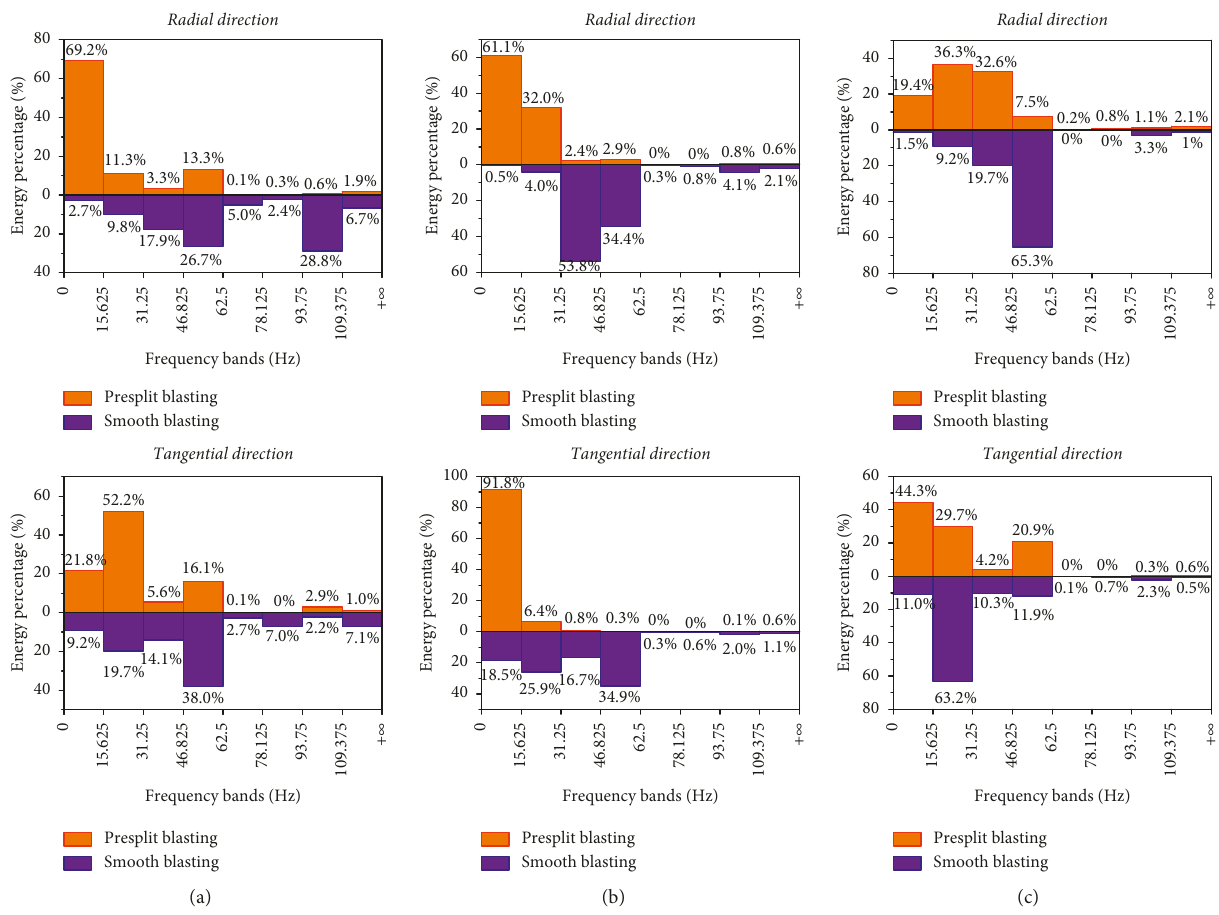
Figure 10: The percentages of energy distribution from main boreholes in different frequency bands based on smooth and presplit blasting at different monitoring distances. (a) 30m. (b) 50m. (c)